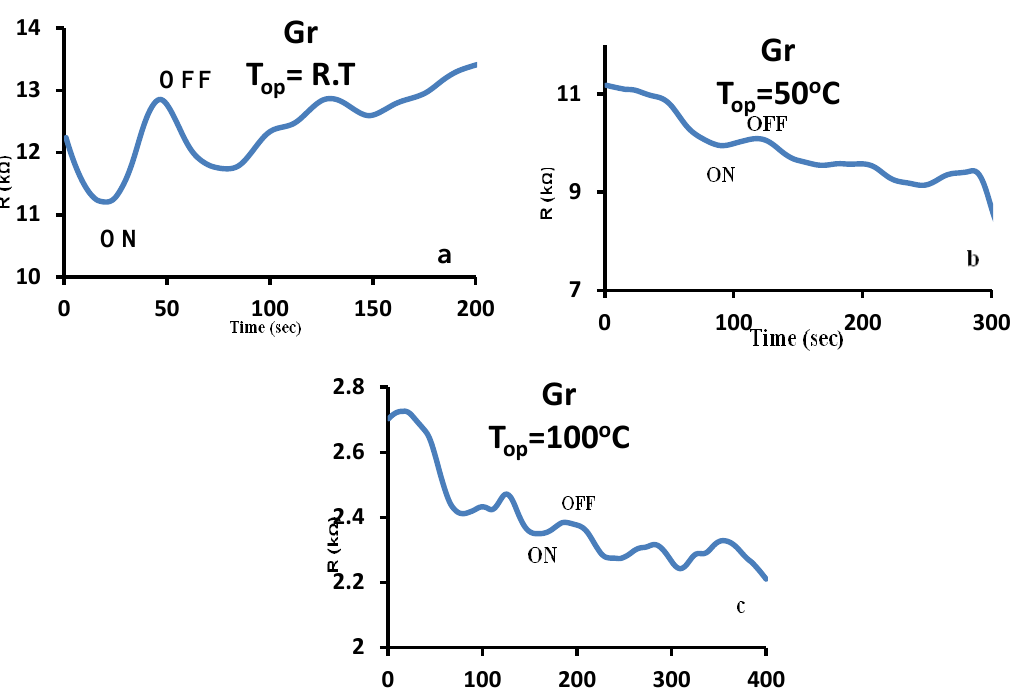
Fig.5: The variation of resistance with time for Gr at different operating temperatures against NO gas. 2